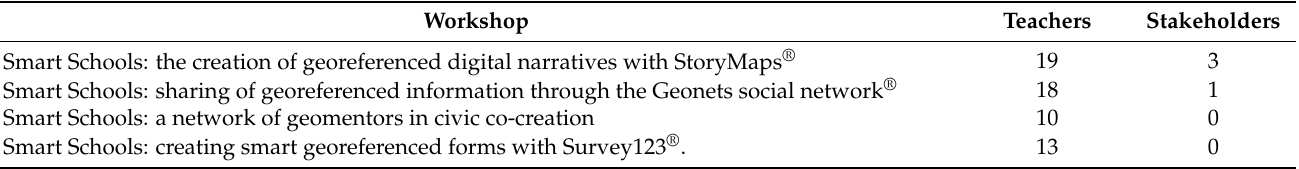
Table 5. Teachers’ and stakeholders’ training sessions and workshops on civic